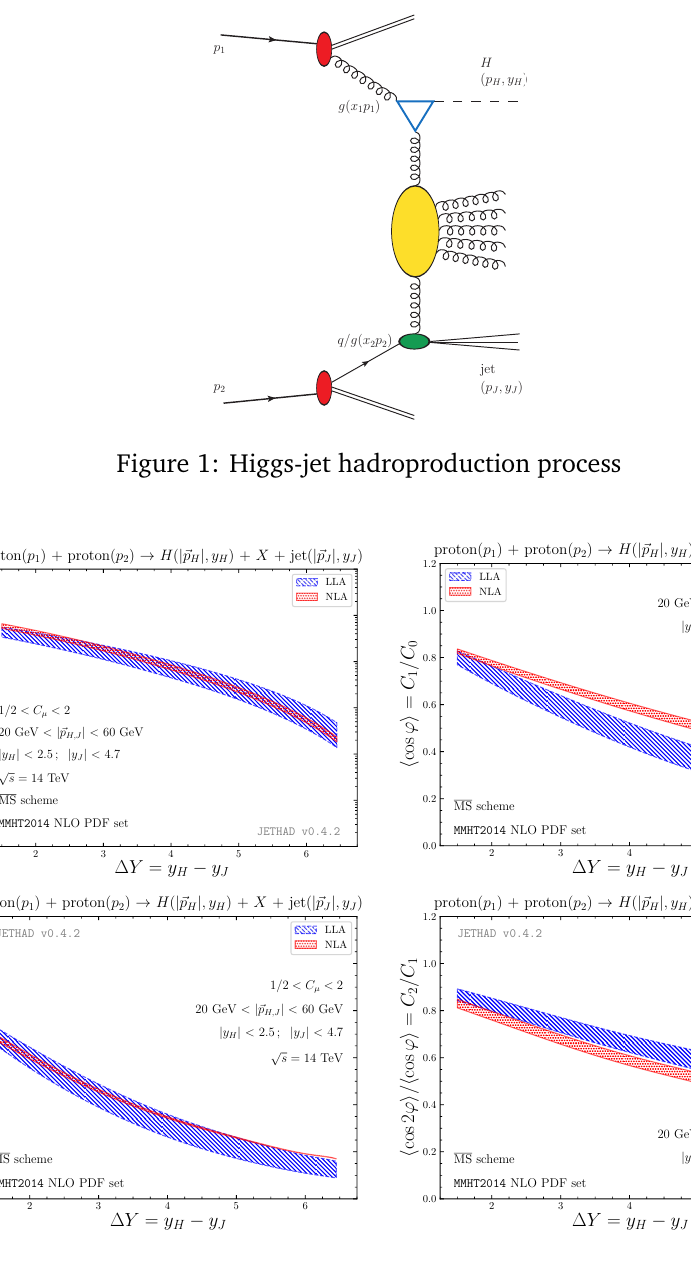
Figure 2: ∆ Y -dependence of the C Higgs-jet